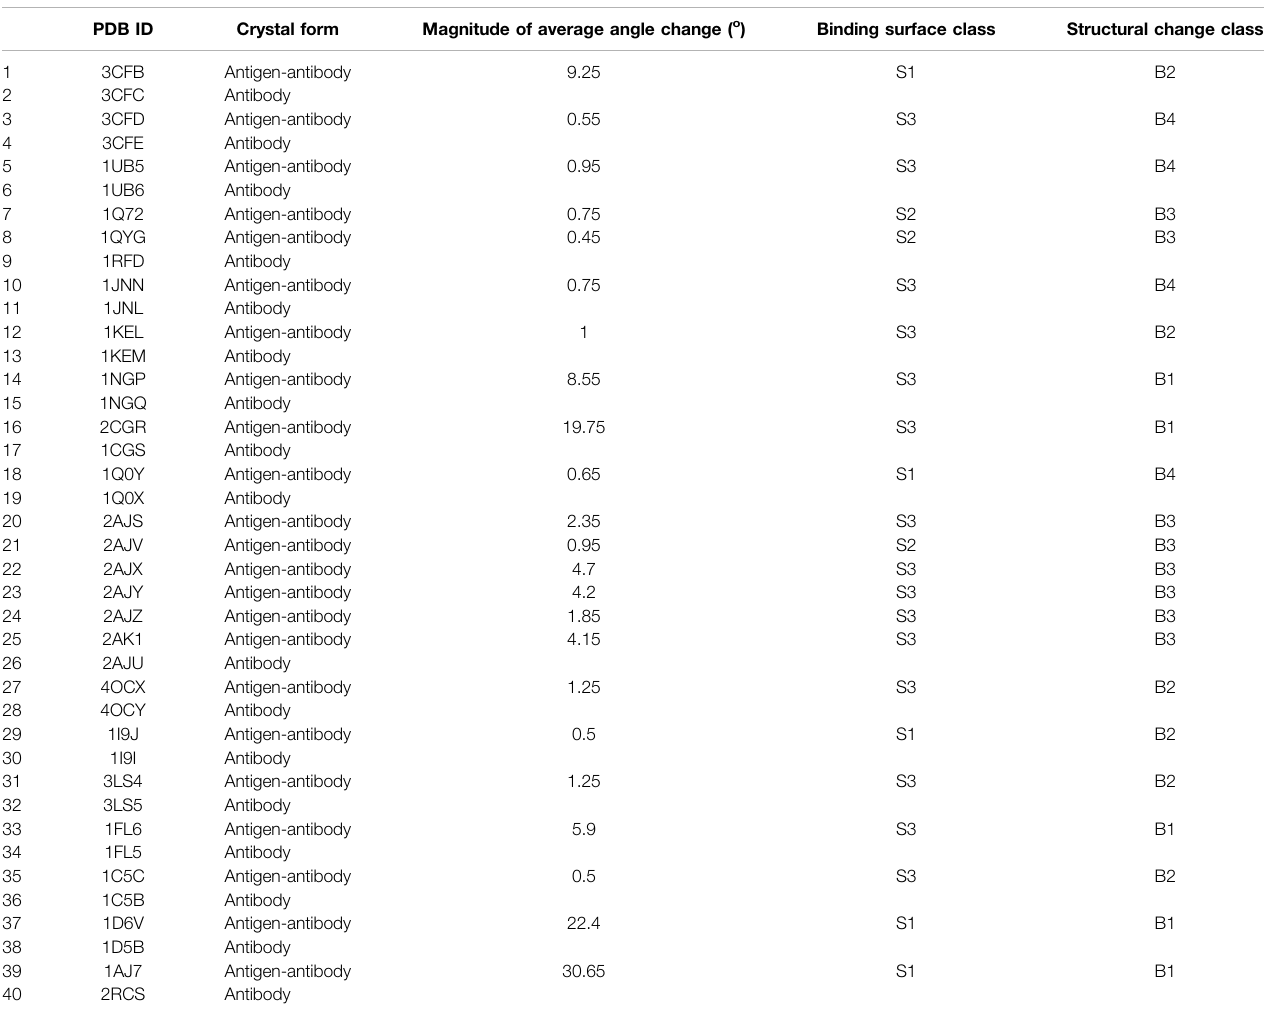
TABLE 2 | Binding conformational change classes. PDB ID Crystal form Magnitude of average angle change ( o ) Binding surface class Structural change